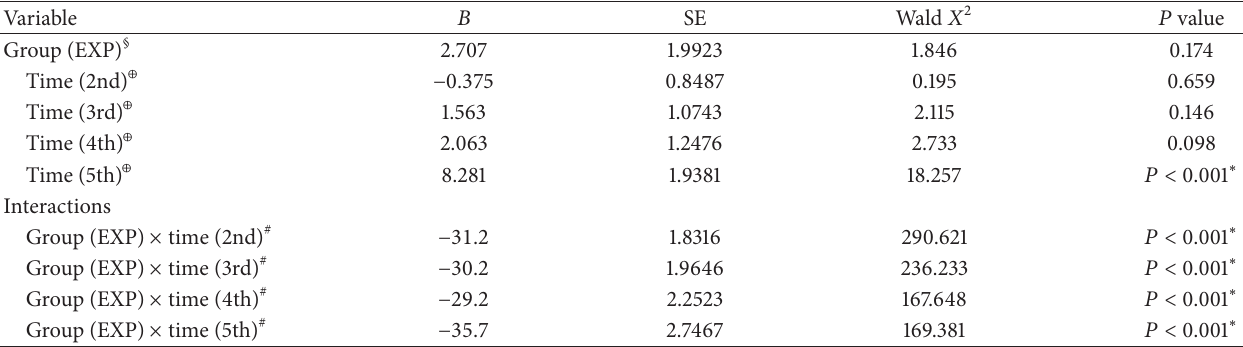
Table 4: GEE analysis of HRSD results.